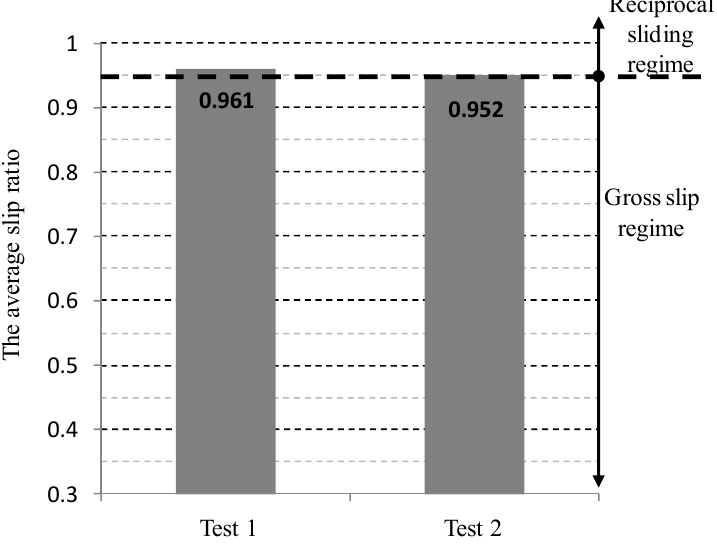
Figure 6. The average slip ratio of tests at a normal force of 50 N, an imposed displacement of 1 mm, and a frequency of 1 Hz.